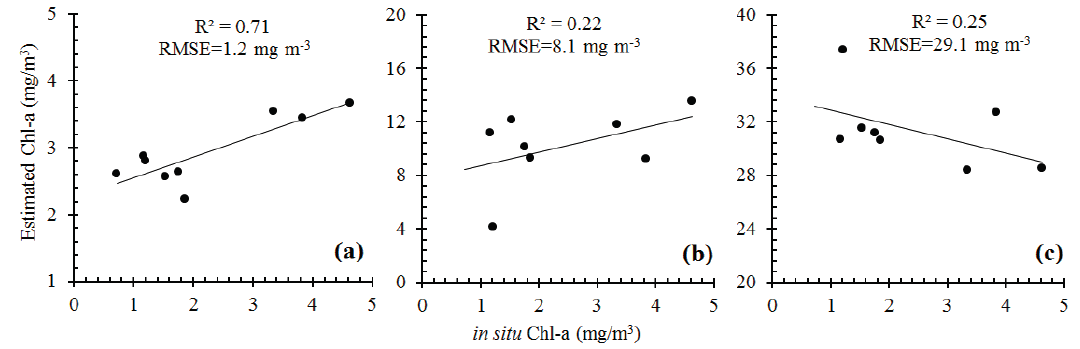
Figure 13. Comparison between field-determined Chl-a and MERIS-derived Chl-a using different algorithms. These scatter plots correspond to the three panels in Figure